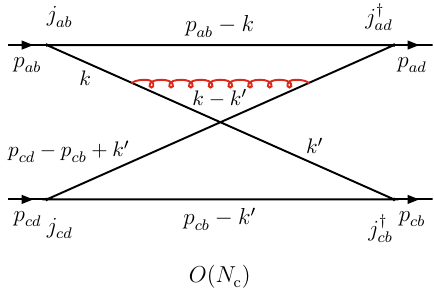
Fig. 22 Two-gluon exchanges between the four